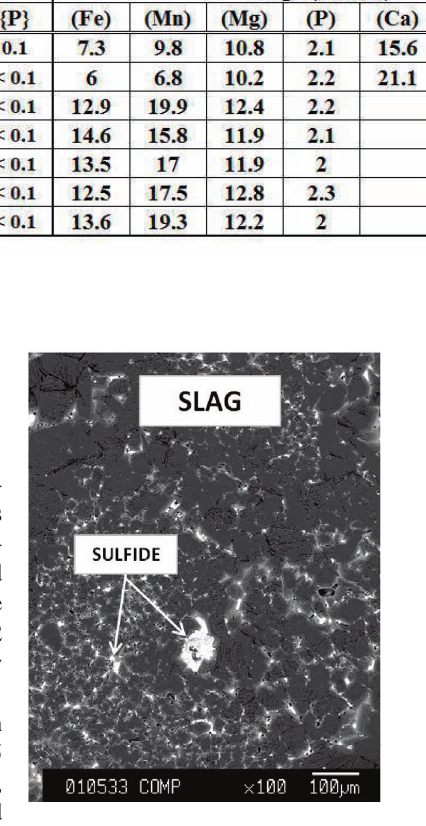
Figure 5. Suspended sulfides within slag.